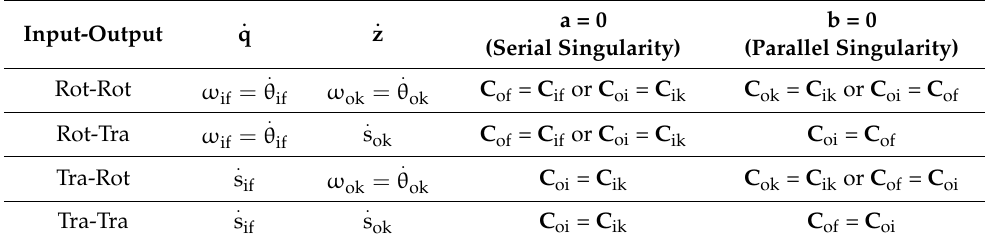
Table 2. Geometric conditions on the IC positions that identify the singularities of single-DOF